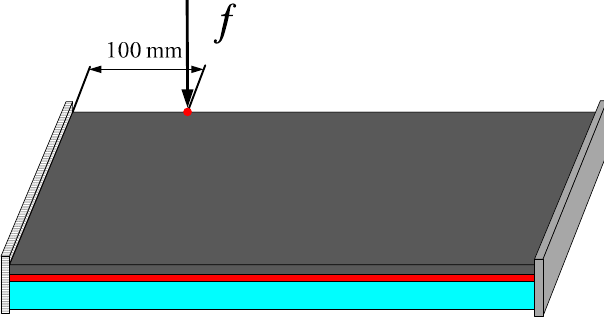
Figure 19. A rectangular plate with two short edges clamped.